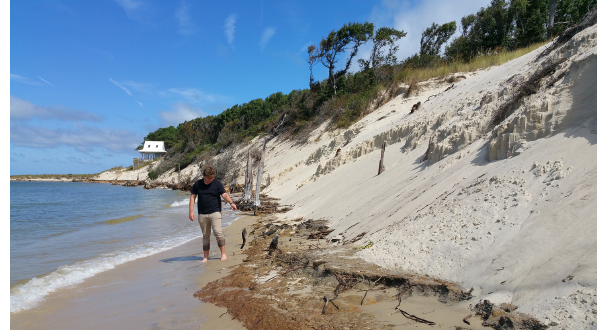
Figure 2. Justin L. Shawler inspects an erosional scarp in the Sav- age Neck Dunes, near Cape Charles, Virginia. Modern shoreline transgression has exposed portions of the basal terrestrial surface over which the dune system migrated, revealing the remnants of a late Holocene coastal forest buried by windblown sand. Radiocar- bon dating of woody debris in the basal surface suggests dune build- ing persisted until several hundred years ago (Davis, 2020). Image by Daniel J. Ciarletta.